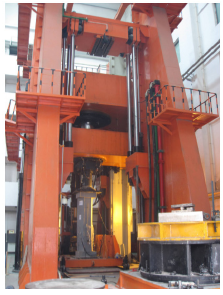
Figure 4. Test scene.